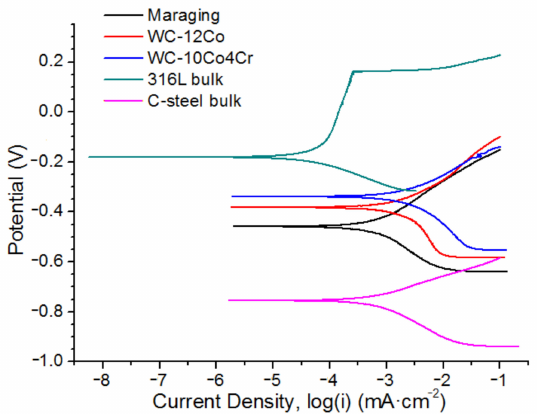
Figure 10. Tafel slopes from potentiodynamic experiments.